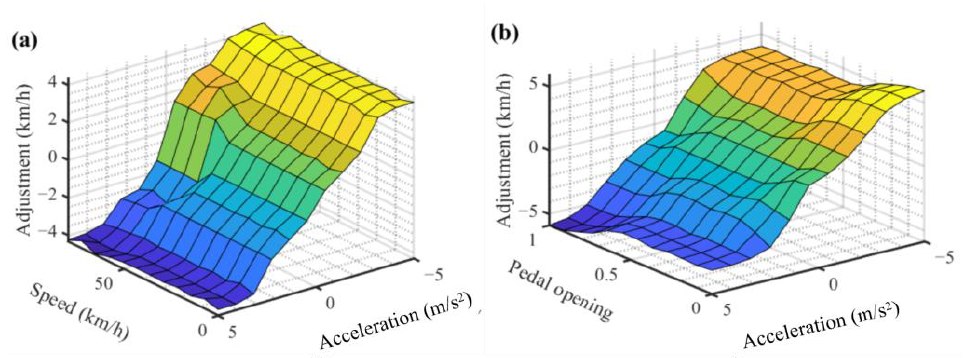
Figure 9. Characteristic maps of fuzzy logic in economic shifting strategy: (a) Fuzzy logic for speed, acceleration and adjustment; ( b ) Fuzzy logic for pedal opening, acceleration and adjustment.